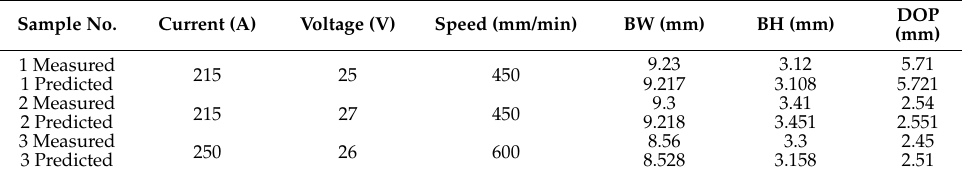
Table 5. Shape variation between prediction and